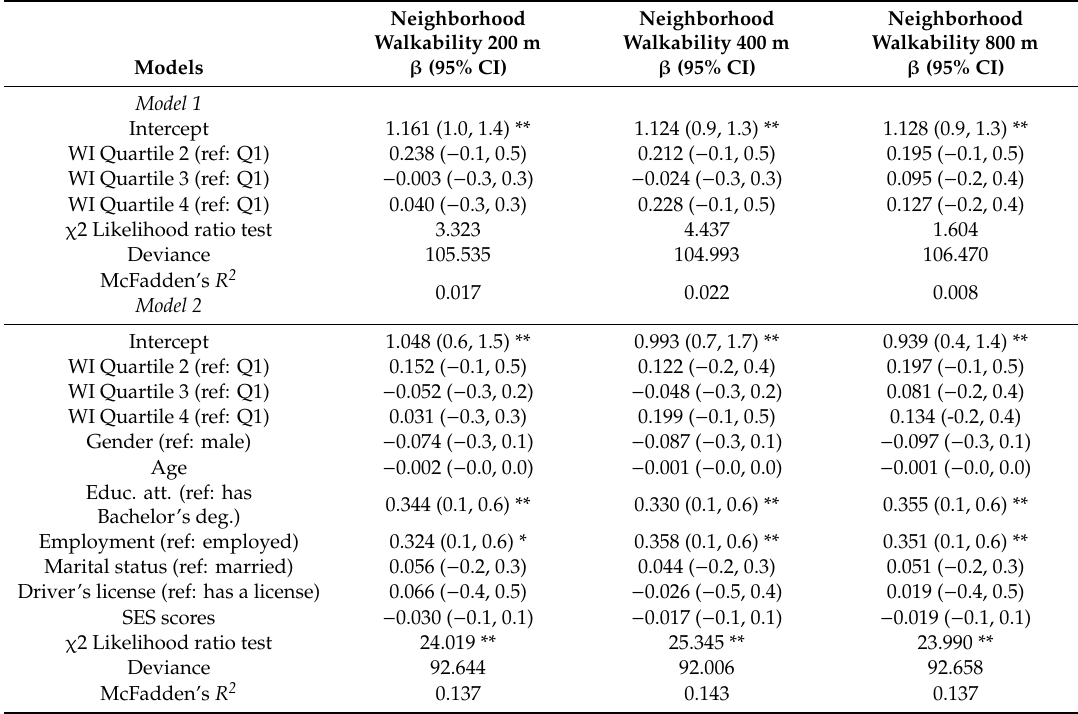
Table 5. Results of the gamma GLM for time spent relaxing.